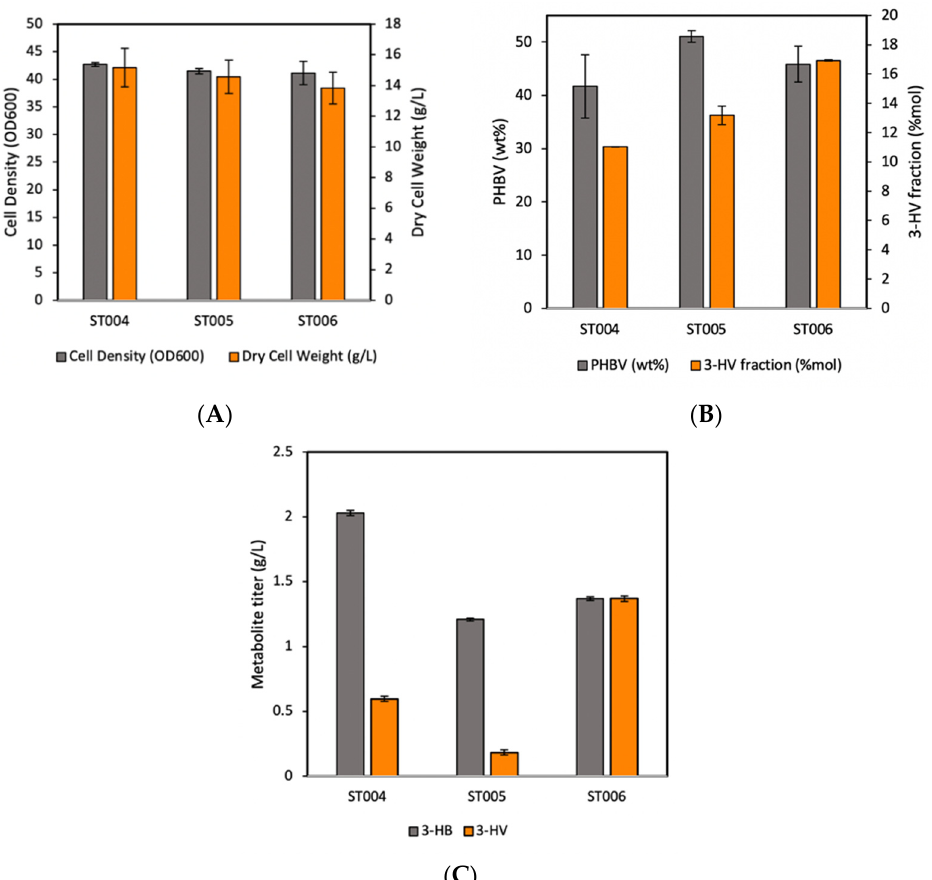
Figure 6. PHBV biosynthesis of the metabolically manipulated strains (ST004, ST005, ST006) ( A ) presenting cell optical density (OD600) and dried cell weight (g/L) ( B ) biopolymer and 3-HV content represented by wt% and mol%, respectively and ( C ) Metabolite production (g/L). All values are reported as means ± SD ( n = 2).